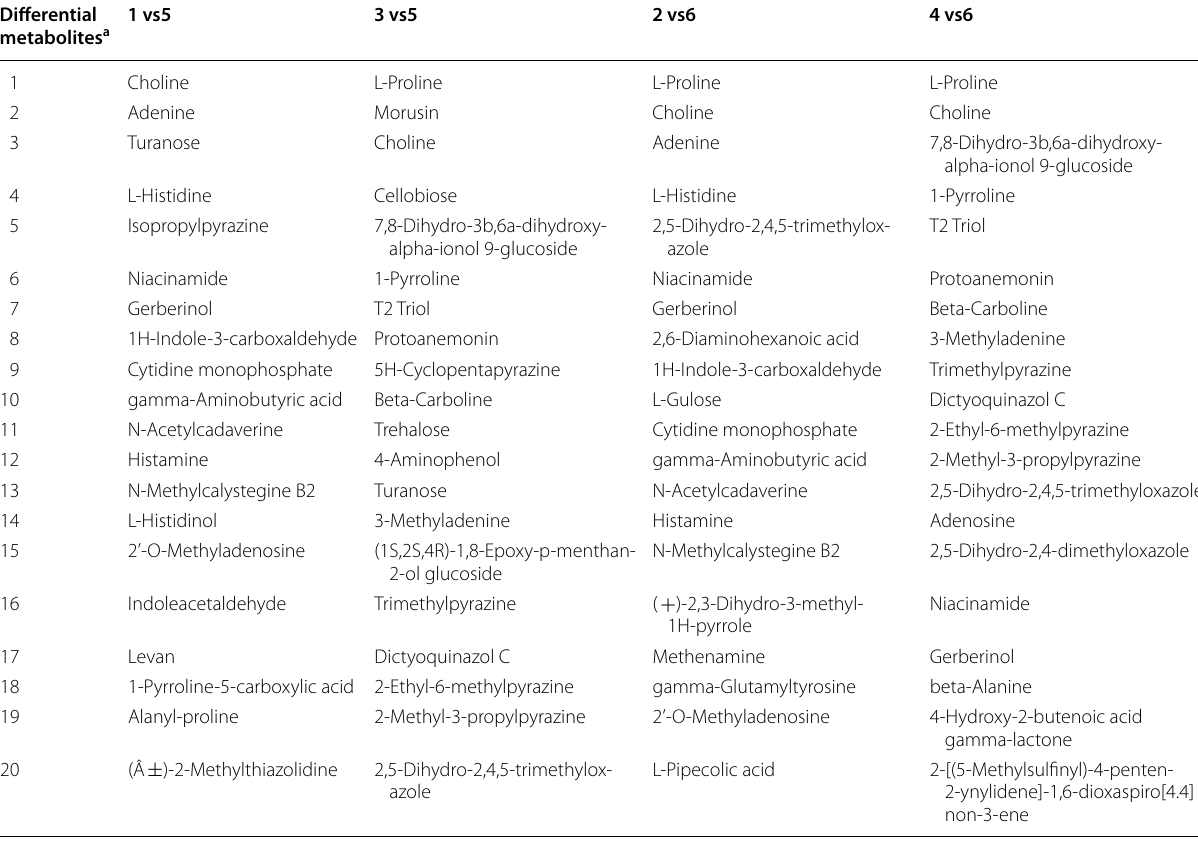
a The card value standard for screening differential metabolites is p < 0.05 and VIP > 1.0